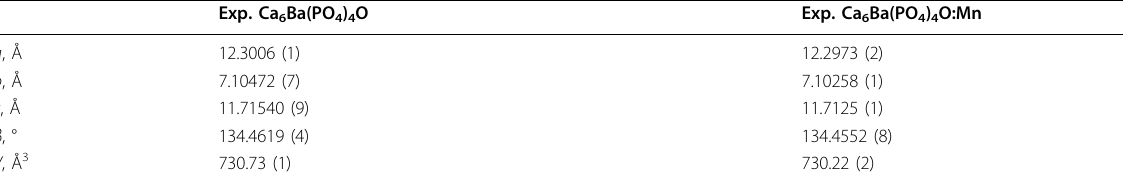
Table 1 Summary of structural data for Ca 6 Ba(PO 4 ) 4 O and Ca 6 Ba(PO 4 ) 4 O:Mn 5 + (space group